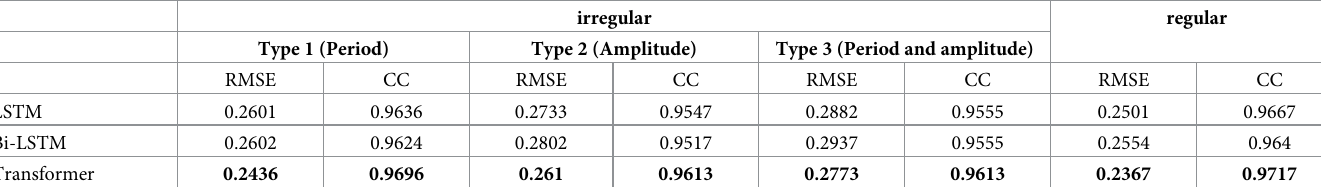
Table 2. Accuracy evaluation of the LSTM, Bi-LSTM, and Transformer methods using the RMSE and